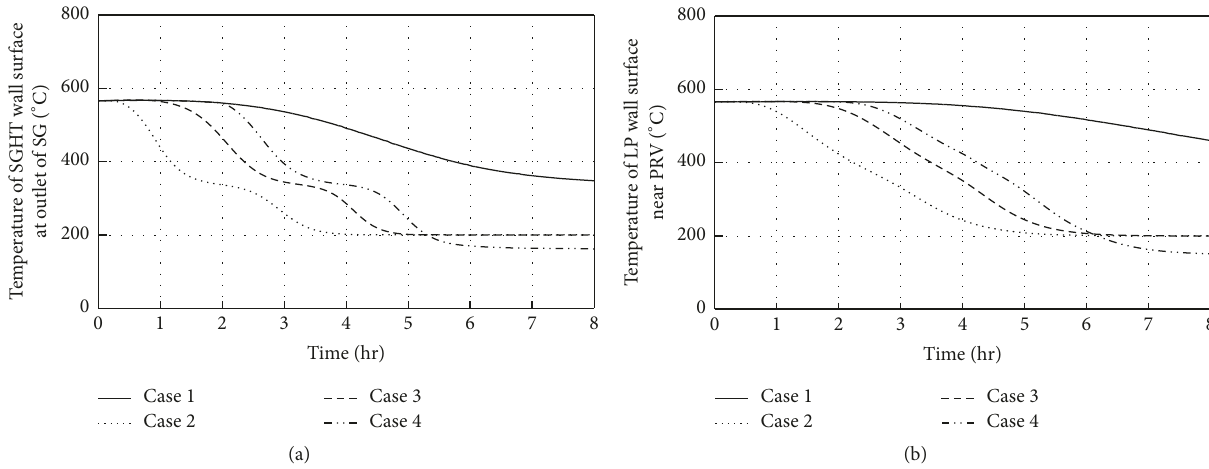
Figure 6: Wall surface temperature at different locations during precooling